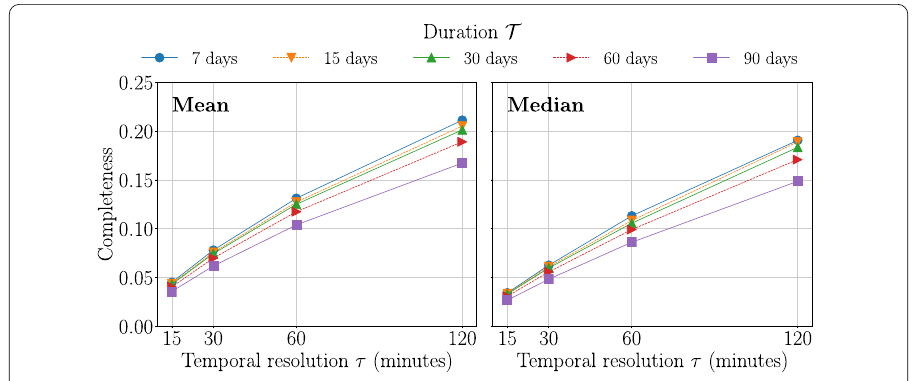
Figure 2 Completeness versus temporal resolution. The left and right plots show the mean and median of the completeness of trajectories, respectively, as the function of temporal resolution τ